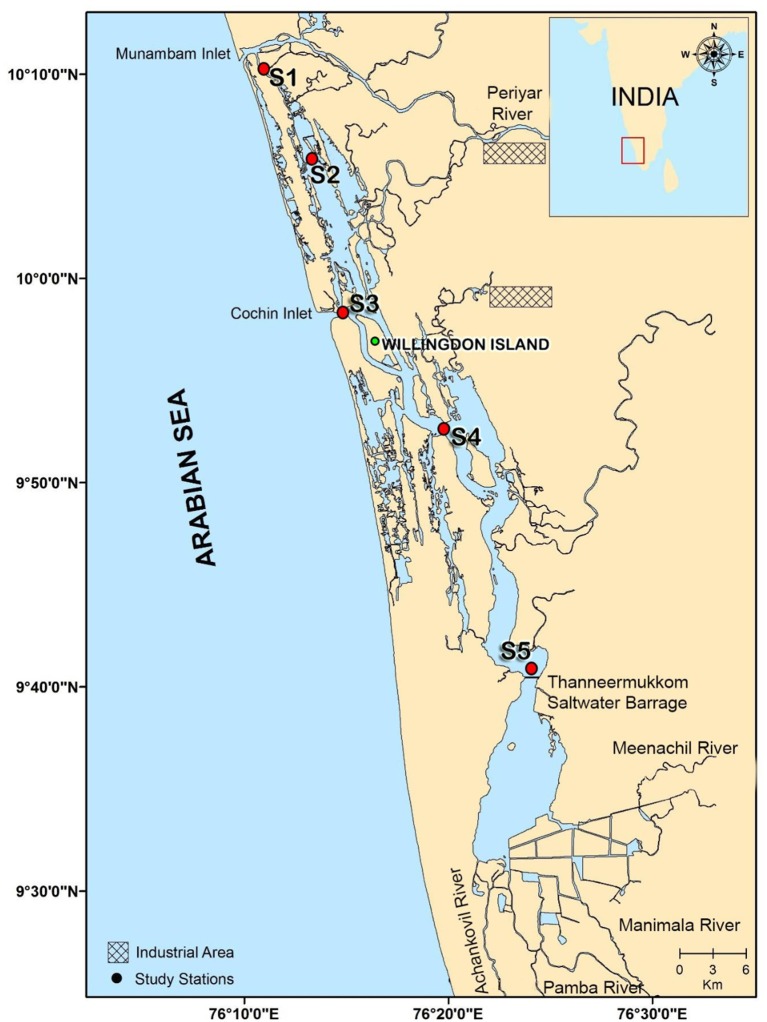
Station locations in the Cochin estuary (CE). Stations 1 and 3 are the two inlets. Station 2 lies in between the two inlets toward the north of the estuary, stations 4 and 5 lies toward upstream (south) of the estuary.